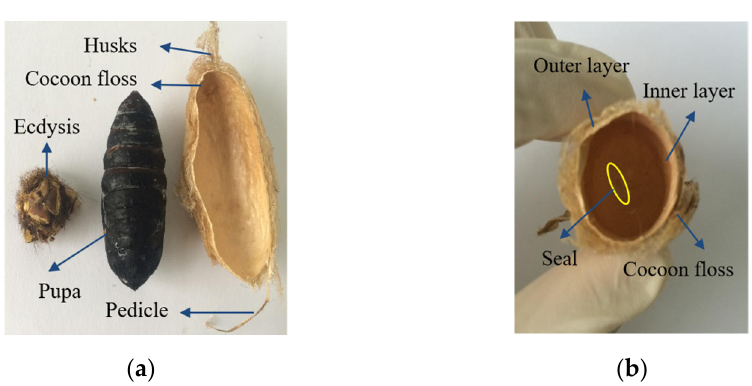
Figure 3. Digital images of the A. pernyi cocoons ( a ) vertical section; ( b ) cross section.